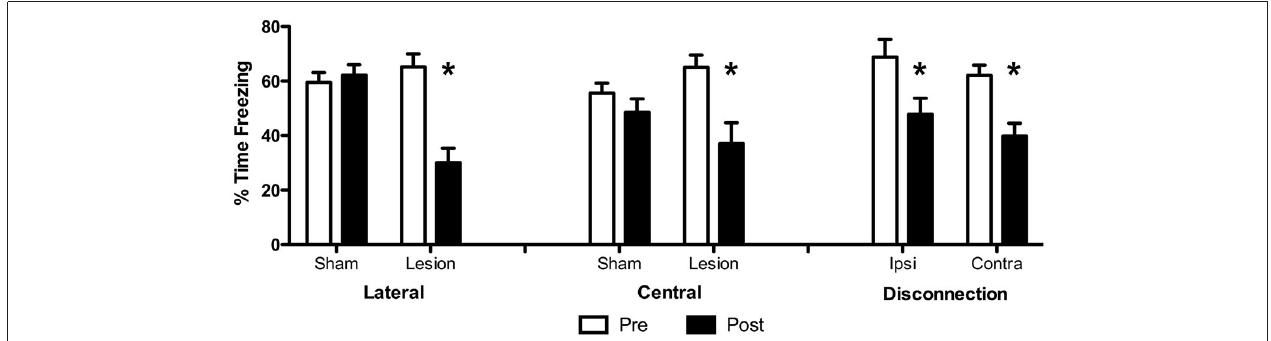
FIGURE 2 | Conditioned freezing data from Expeiment 1 . Data are presented in terms of percent time spent freezing to the conditioned stimulus (CS) before and after surgery for each group. ∗ p <